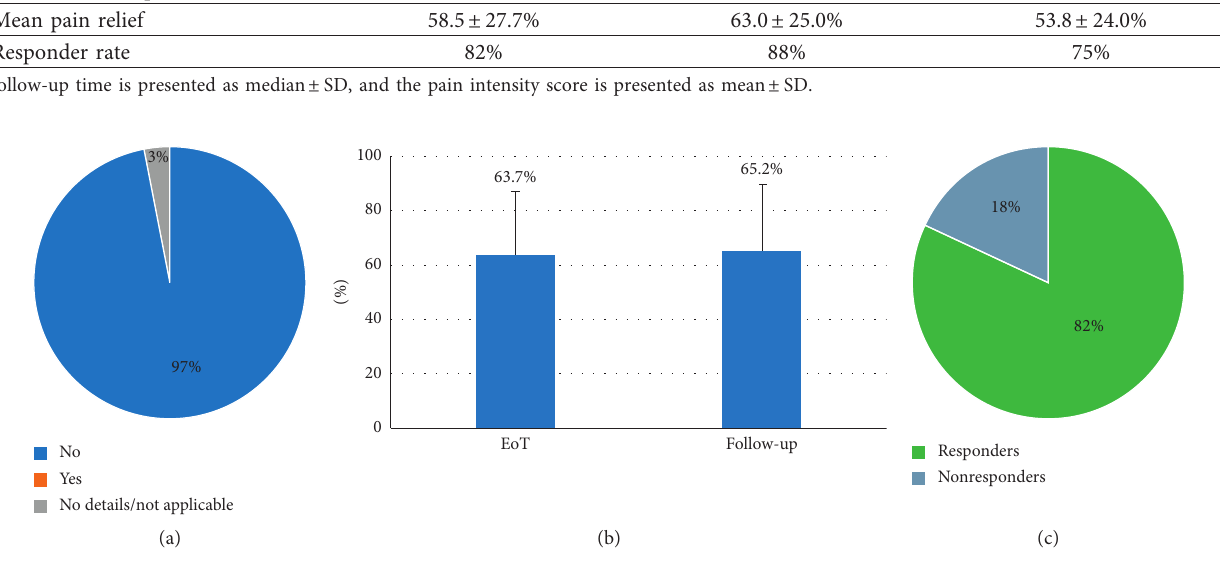
Figure 2: Clinically significant lead migration rate at 6 months of follow-up (a); mean patient-reported pain relief at the end of the trial and the 6-month follow-up visit in 101 patients (b); and responder rate at the 6-month follow-up visit in 101 patients (c).